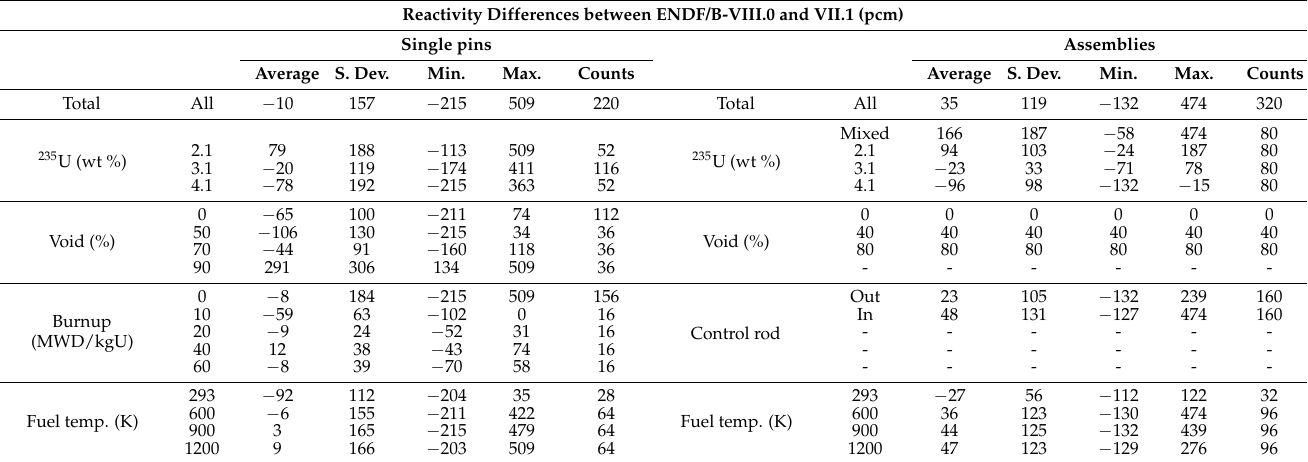
Table 9. Results of the BWR extensive pin and assembly